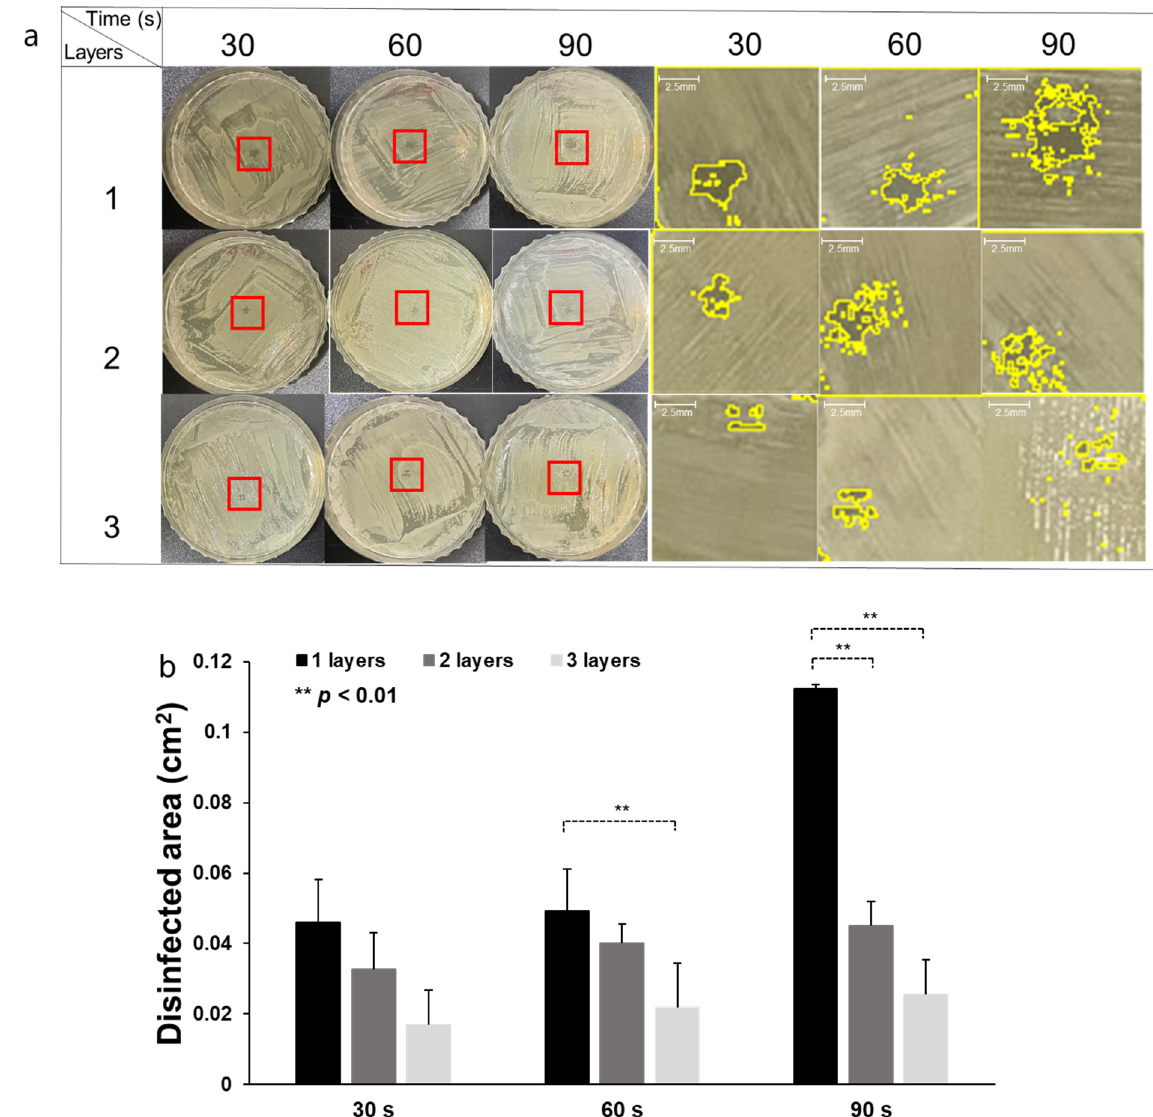
Figure 6. CAPMP treatment on S. aureus spread on the agar plate covered by single, double, or triple gauze layers. ( a ) Disinfected clear zone on the S. aureus agar plate, indicated by the zoomed-in red ROI shown on the right columns, with yellow lines indicating the zone boundary. ( b ) Average and standard deviation of the disinfected area analyzed using ImageJ, according to the number of gauze layers and CAPMP treatment time ( n = 3). *: p < 0.05, **: p < 0.01 by t -test between the groups.